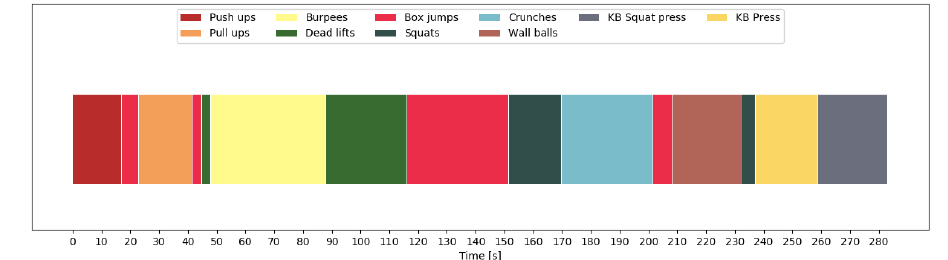
Figure 10. Chronological sequence of recognized exercises during free workout one for participant 1 (P1). The recognition is done without including the non-exercise class, thus causing the model to interpret transition as exercises.